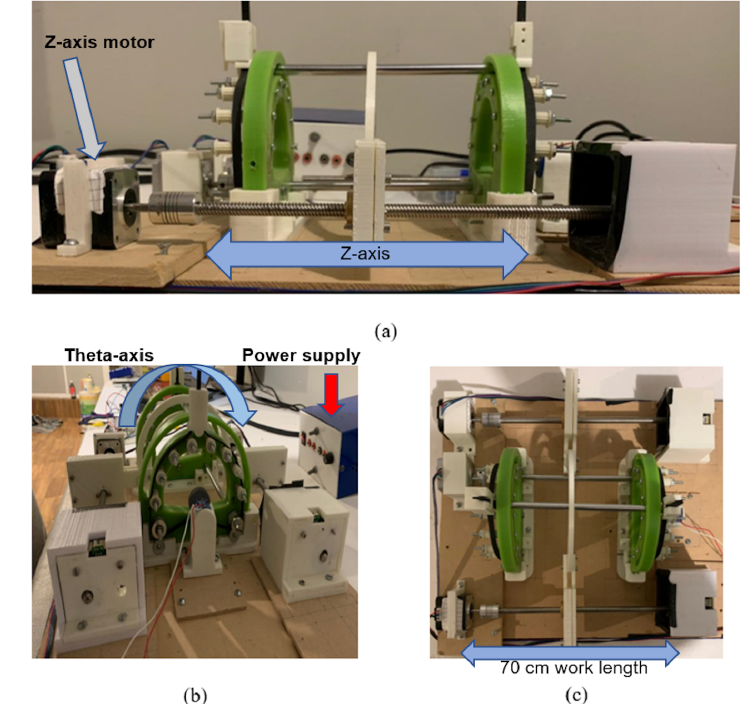
Figure 6. A stereotactic positioning system was constructed showing the ( a ) lateral, ( b ) frontal, and ( c ) superior